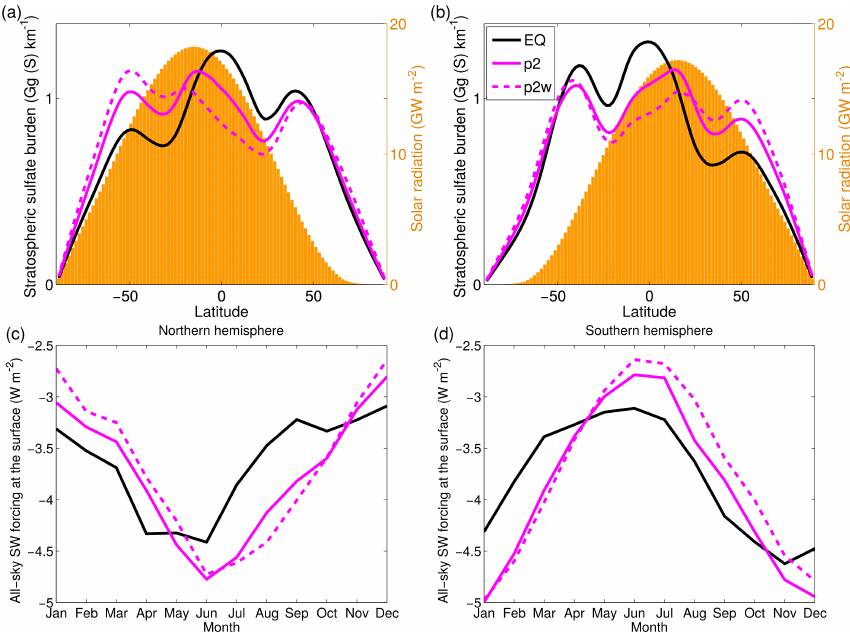
Figure 5. The zonal distribution of stratospheric particulate sulfate burden and the zonally distributed incoming solar radiation in the (a) December–January–February and (b) June–July–August and the all-sky shortwave radiative forcing at (c) the Northern Hemisphere and (d) the Southern Hemisphere. In panels (a, b) sulfate burden and solar radiation are shown per meridional